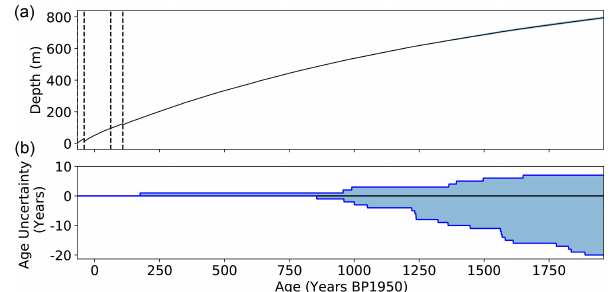
Figure 2. (a) Age at depth for the composite record. Steps in the curve correspond to boundaries between cores as they were drilled years apart. (b) Accumulated age uncertainties over the 2000 years of data. Figure 3. Periods of time covered by the individual cores mak- ing up this composite record, drilled at DSS from the drilling cam- paigns, as described in Table 1. For each individual core, the solid colour indicates the years where data from the core are included in this composite record. Transparent colours indicate where data overlapping the other cores exist but is not included in the compila- tion due to better quality core or data being